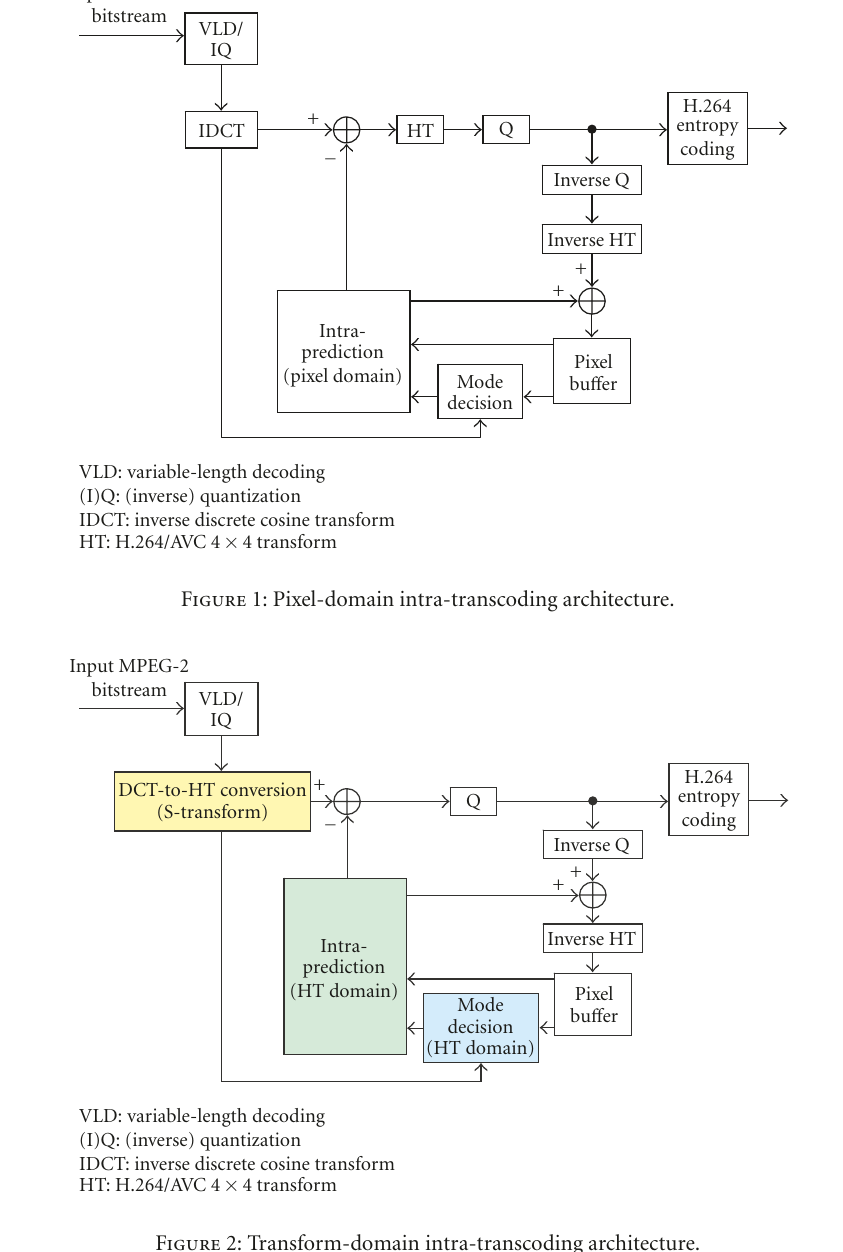
Figure 2: Transform-domain intra-transcoding